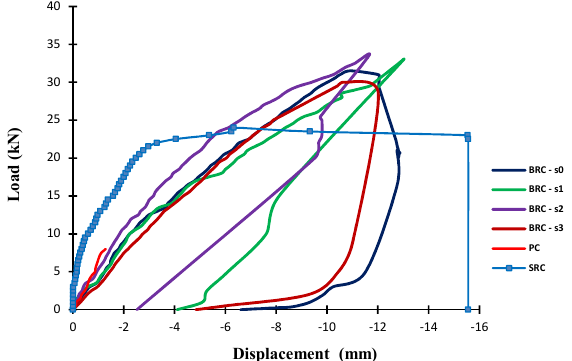
Figure 9. The load vs. deflection relationship of the BRC beam and the SRC beam until the gradual release of the load.